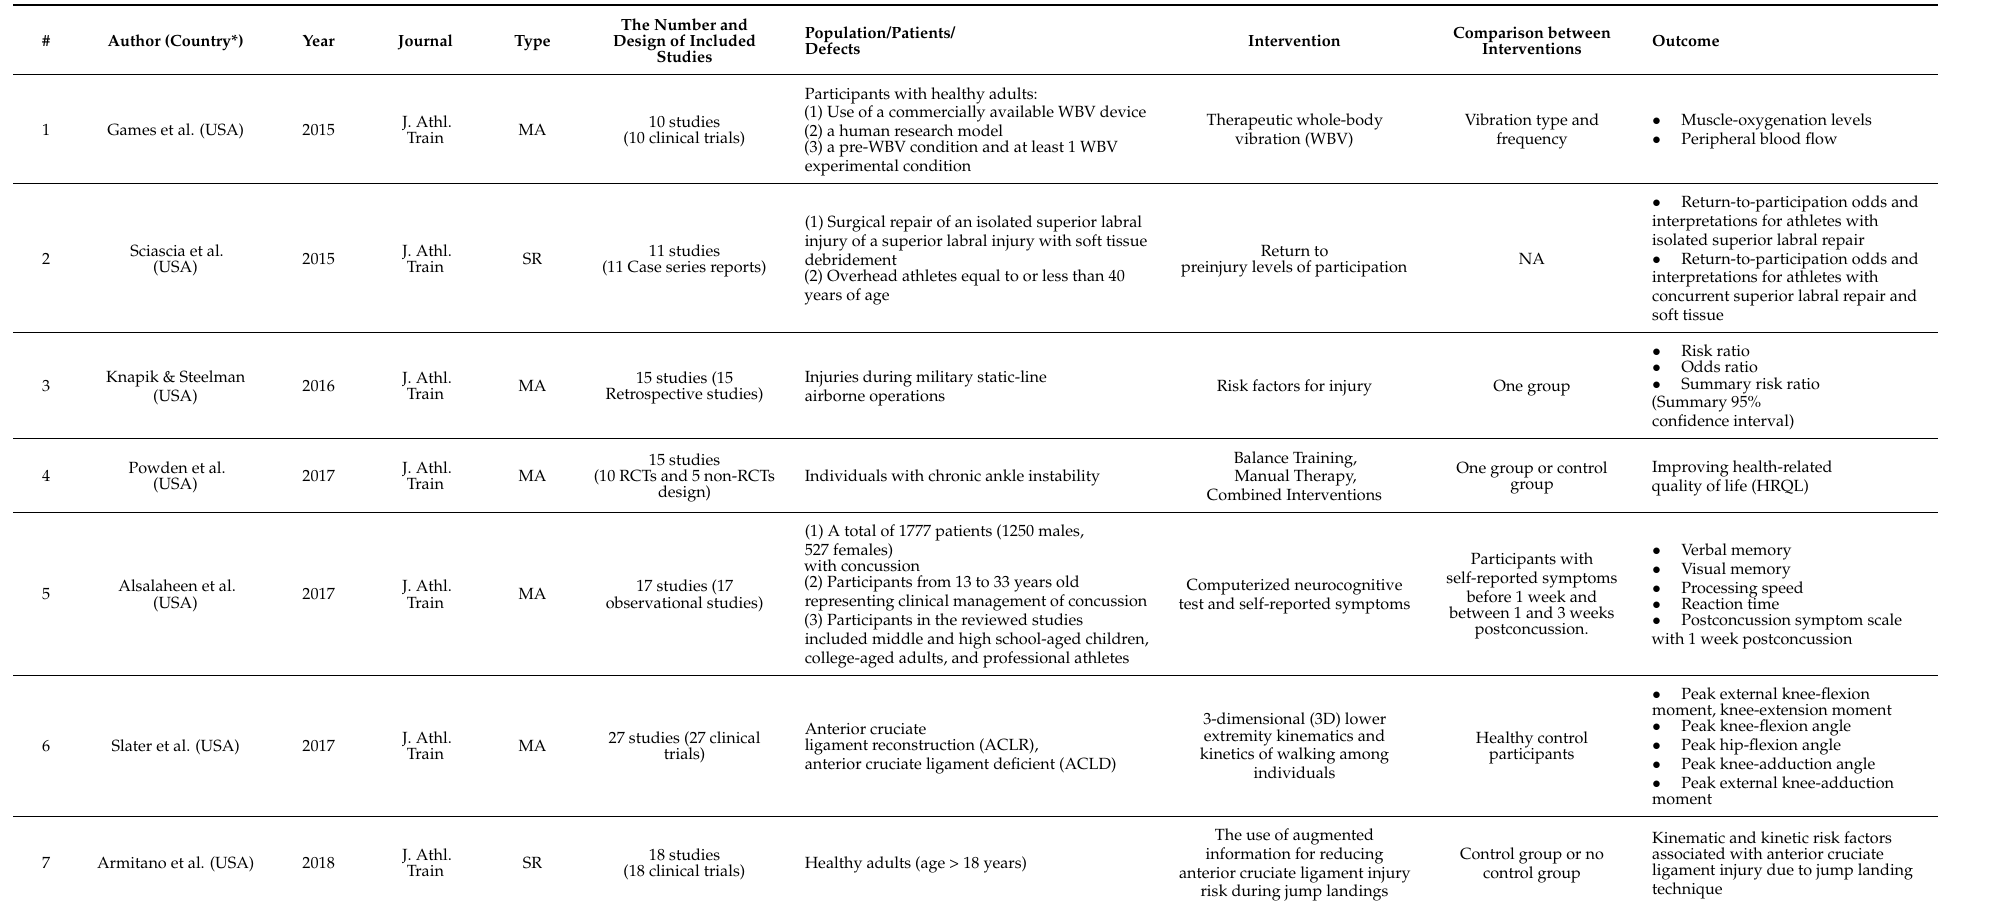
Table A1. Study characteristics of included systematic review and meta-analysis in reporting quality